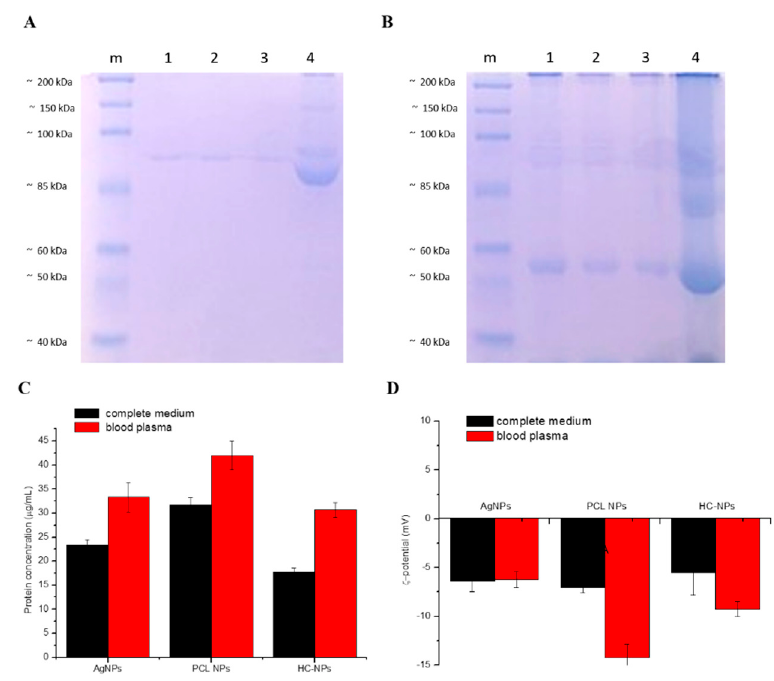
Figure 2. SDS-PAGE of hard protein corona after incubation with complete culture medium ( A ), and with mouse blood plasma ( B ) overnight at 37 °C with AgNPs (lane 1 of A and B); PCL NPs (lane 2 of A and B), HC-NPs (lane 3 of A and B), and control with only medium (lane 4 of A) and with solely mouse blood plasma (lane 4 of B). Quantification of adsorbed proteins on different NPs formulation by the bicinchoninic acid (BCA) assay ( C ). ζ -potential analysis of NPs after incubation with complete medium and blood plasma overnight ( D ). A representative result of three independent experiments is shown ( P -values < 0.05) .